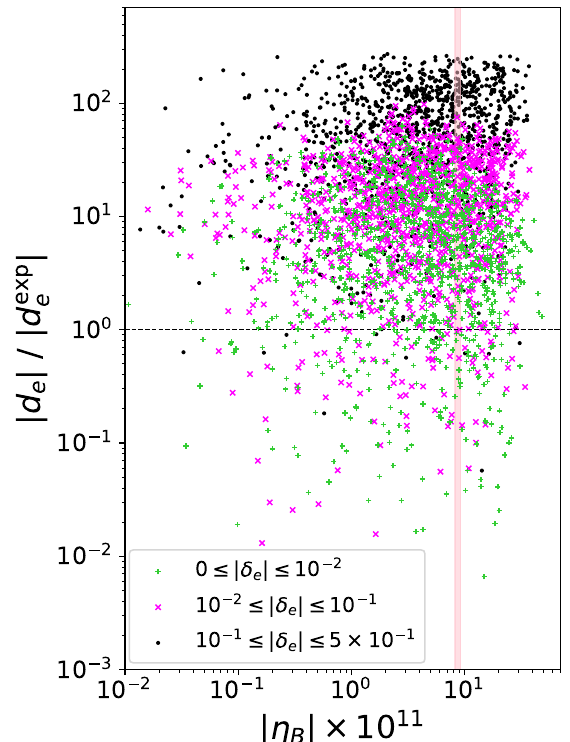
| and | η B | × 10 11 . Input parameters are the same as e